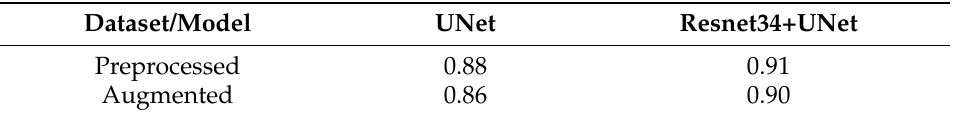
Table 5. Intersection over Union (IoU) on the test set with the original UNet implementation and the Resnet34+UNet model. Both models were trained and tested with the preprocessed dataset first and with the weather-based augmented dataset